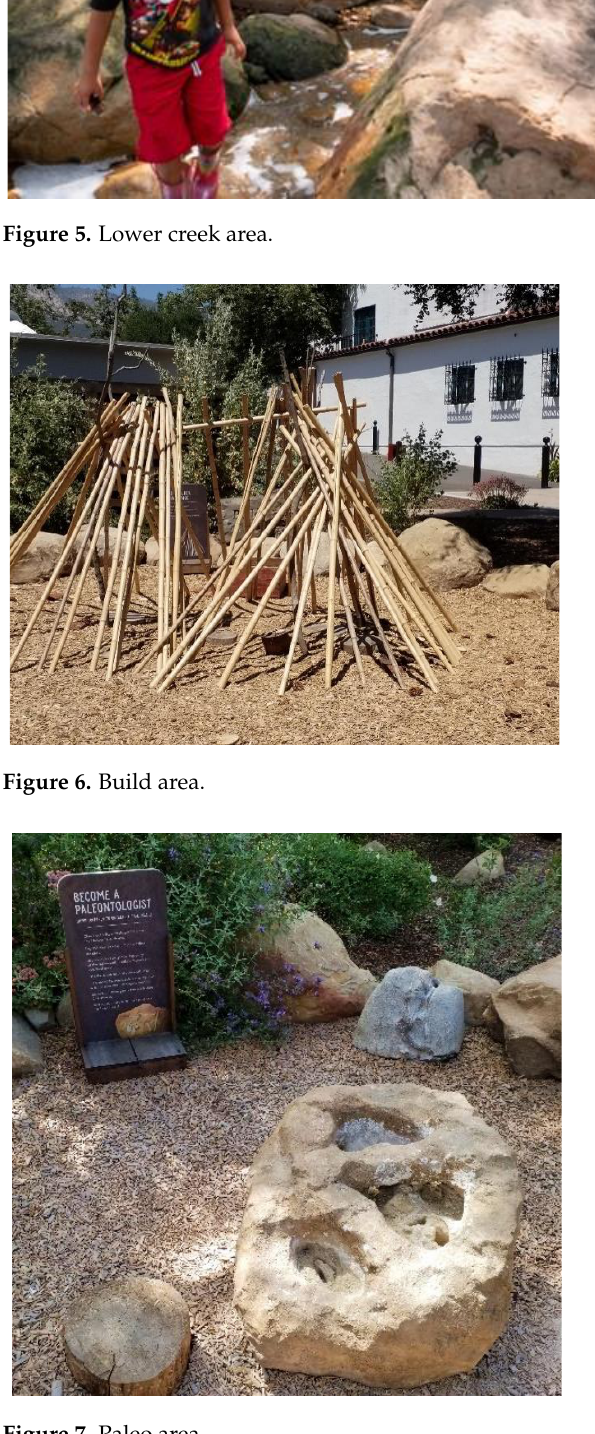
Figure 7. Paleo area.